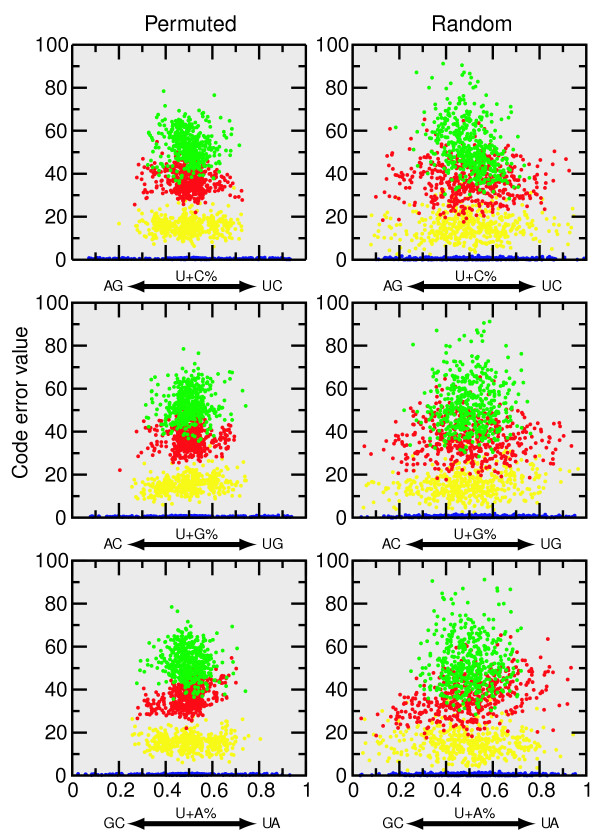
Absolute error values for permuted bacterial codon usages. The variation in code-error values is shown along the three compositional axes. Compare this figure with biological codon usages in Figure 3. Top row, UC content; middle row, UG content; bottom row, UA content. Left column, permuted positional-base usages. Right column, random positional-base usages. First position, yellow; second position, red; third position, blue; and total, green. Lack of correlation along any axis and wide range suggests that constraints on positional-base usage do not explain the pattern of codon usage error values in organisms.